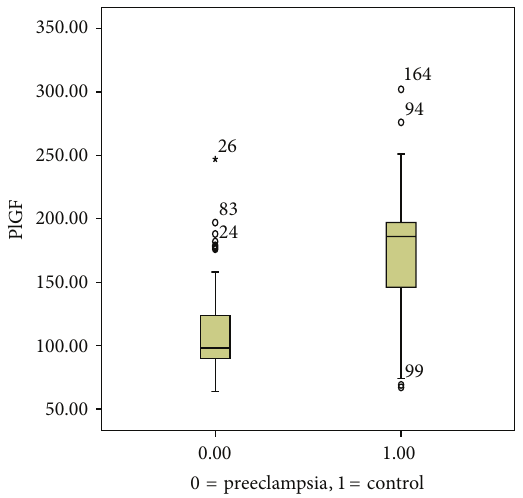
Table 4: Area under the curve from the receiver operating charac- teristic curve analysis of sFlt-1, PlGF, and sFlt-1/PlGF ratio.